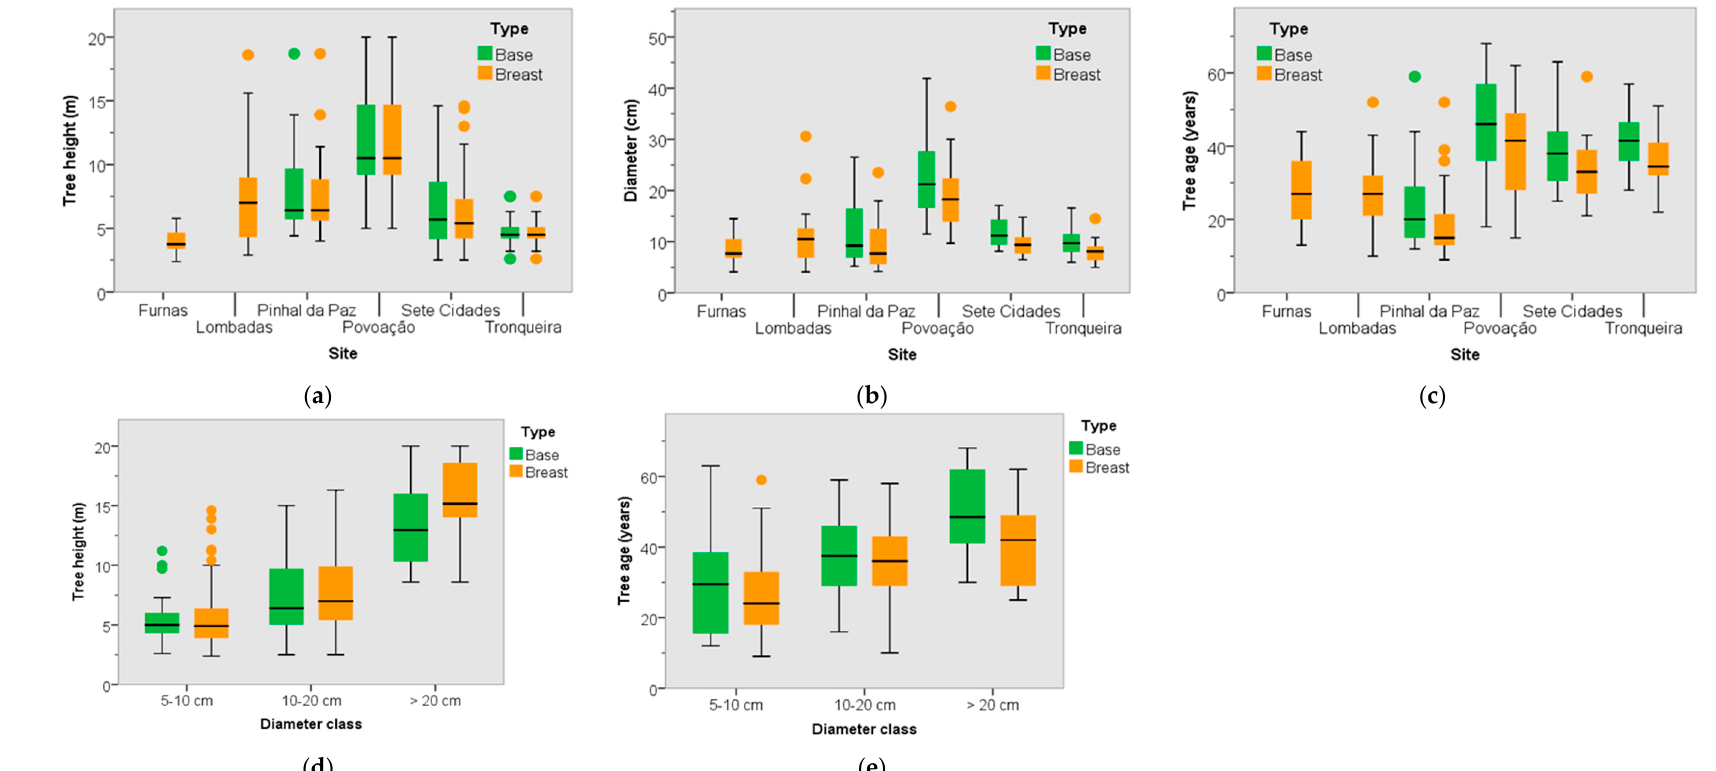
Figure 6. First row: Distribution of tree height ( A ), trunk diameter ( B ) and tree age ( C ) for each sampled stand in São Miguel Island. Second Row: Distribution of tree height ( D ) and estimated tree ages ( E ) by diameter class (<10, 10–20, >20 cm). From a total of 256 samples of L. azorica (Seub.) Franco collected in São Miguel Island, collected at breast height (130 cm above substrate) or at tree base (20 cm above substrate). In the boxplots, circles represent outliers.